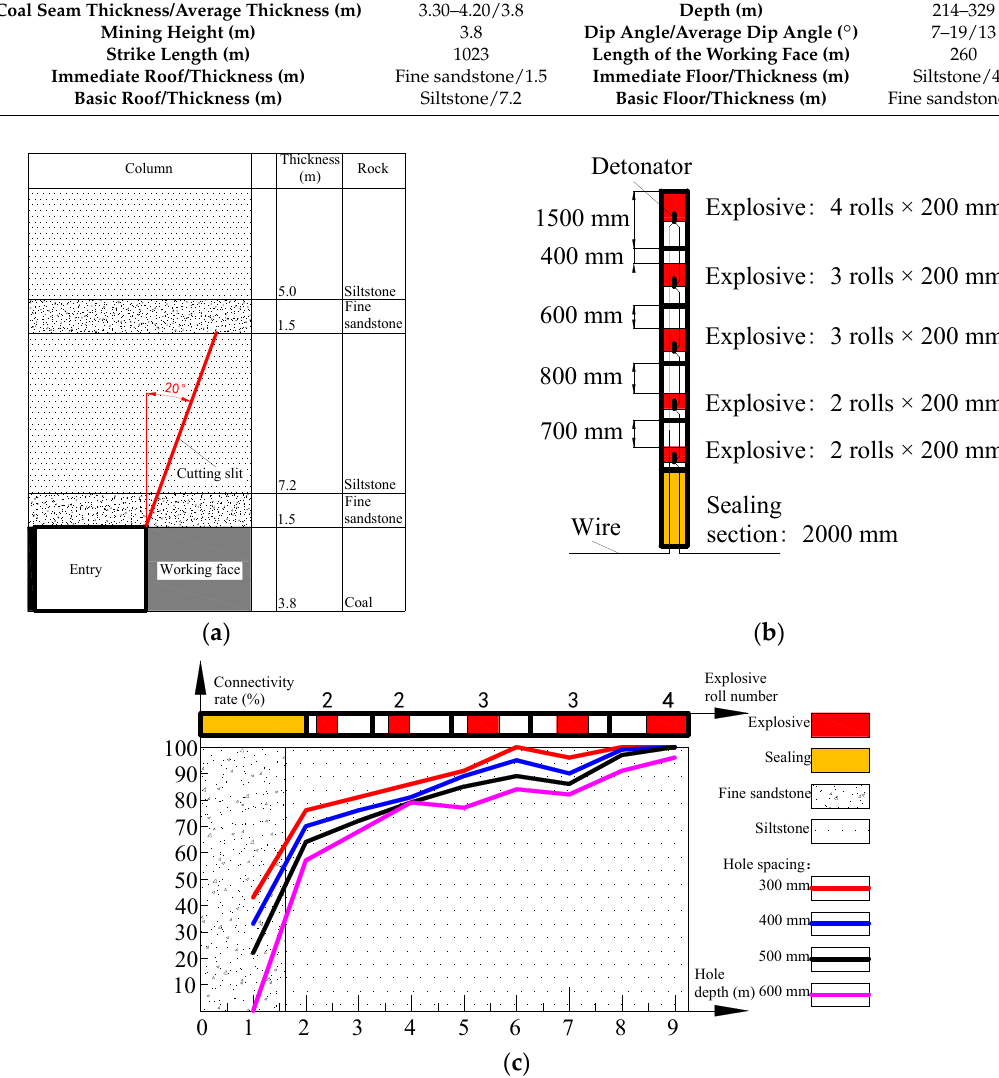
Figure 11. Roof cutting blasting design of the 011810 working face: ( a ) roof cutting design; ( b ) schematic of charge structure; ( c ) statistical drawing of roof cutting connectivity rate.